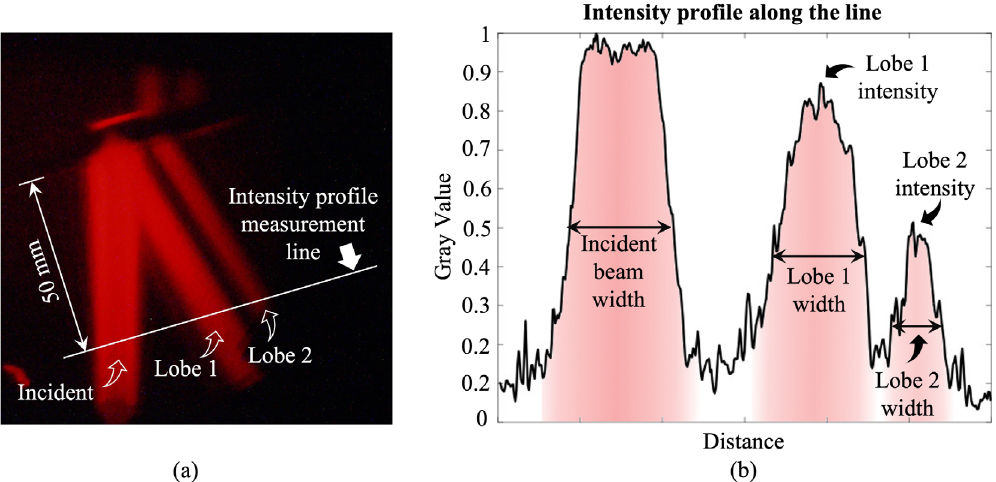
Figure 7. Illustrations: (a) Obtaining beam intensity pro fi le on a line parallel to the glass surface at an offset of 50 mm. (b) Extracting beams ’ relative intensities and widths, where the gray value in the vertical axis signi fi es the intensity of a pixel in the image. The width is taken at half of the corresponding beam ’ s maximum intensity (full width at half maximum,